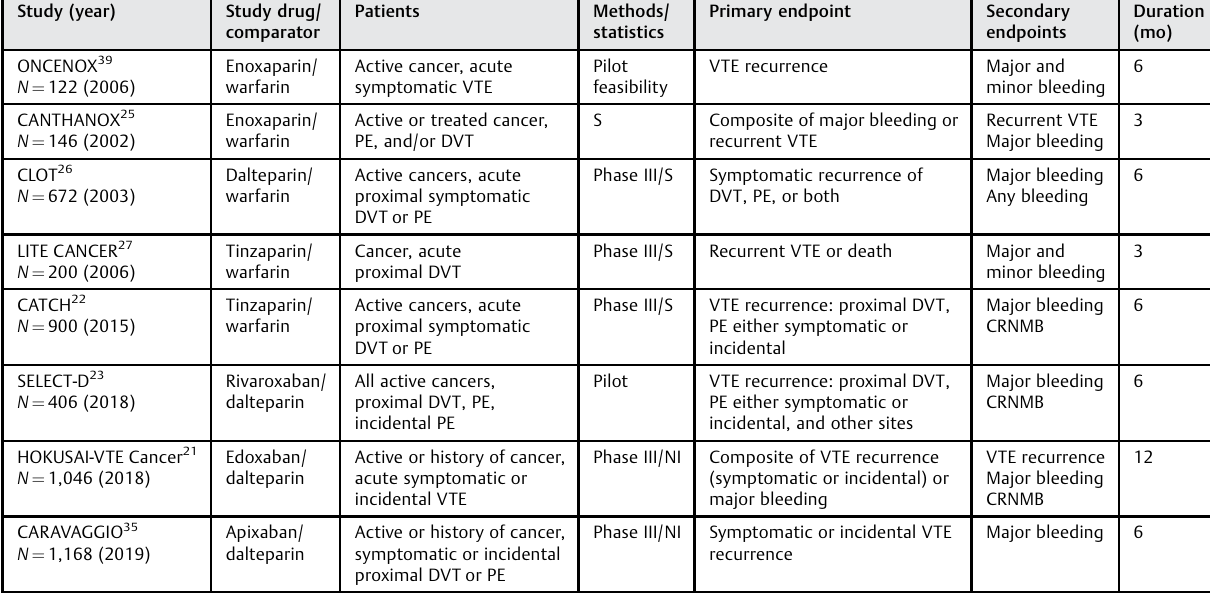
Table 1 Protocol design of randomized control trials on anticoagulants for the treatment of cancer-associated